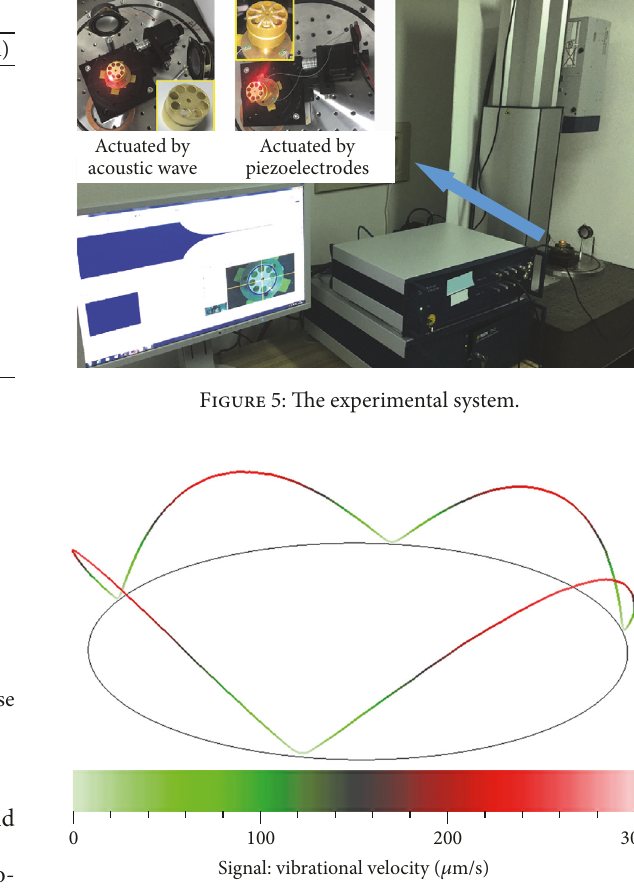
Figure 6: The graph of the vibrational